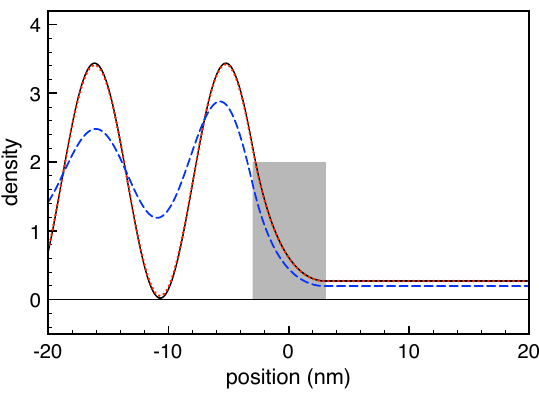
Figure 11. The same as in Figure 10 but for a thinner ( w = 6nm) and lower ( V 0 = 75meV) barrier (see